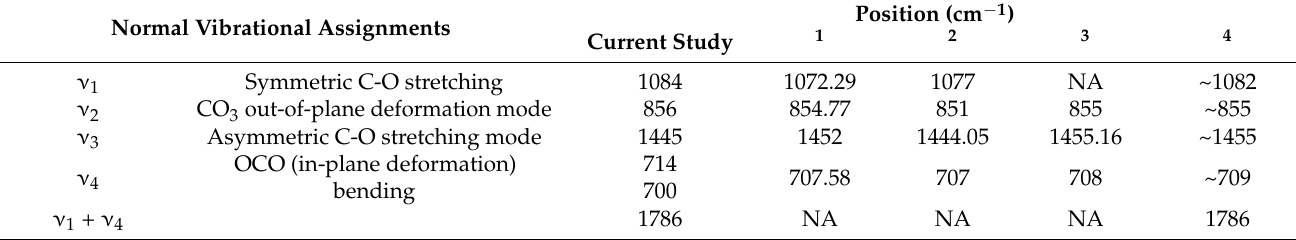
Table 5. FTIR vibrational assignments of blood cockle shell derived CaCO 3 nanoparticles. Normal Vibrational